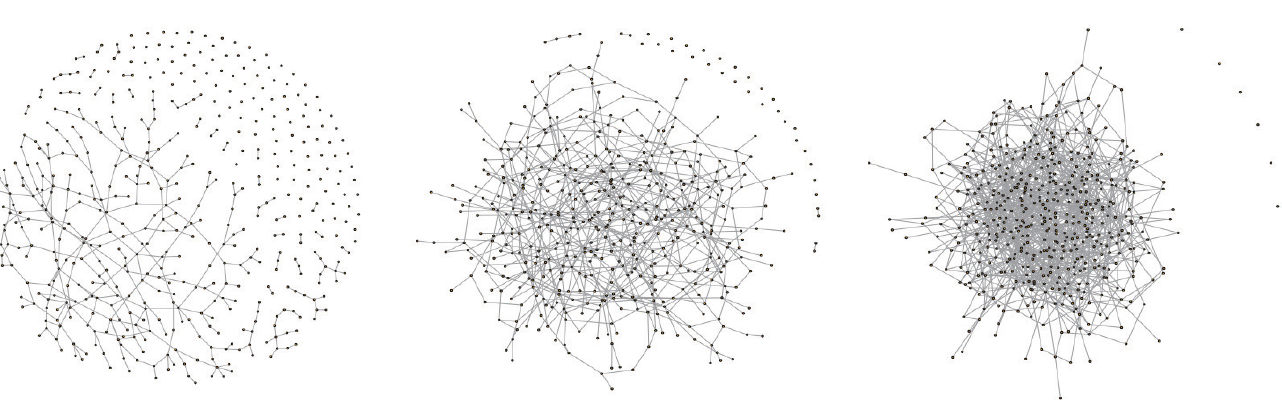
Figure 1. Illustration example of the ER random graph for 500 nodes. (We set the average degree as λ = 1.5 ( left ), λ = 3 ( middle ), and λ = 4.5 ( right ). The figure shows that, for a given number of nodes n , the ER random graph has local tree structures if the average number of degrees λ ≈